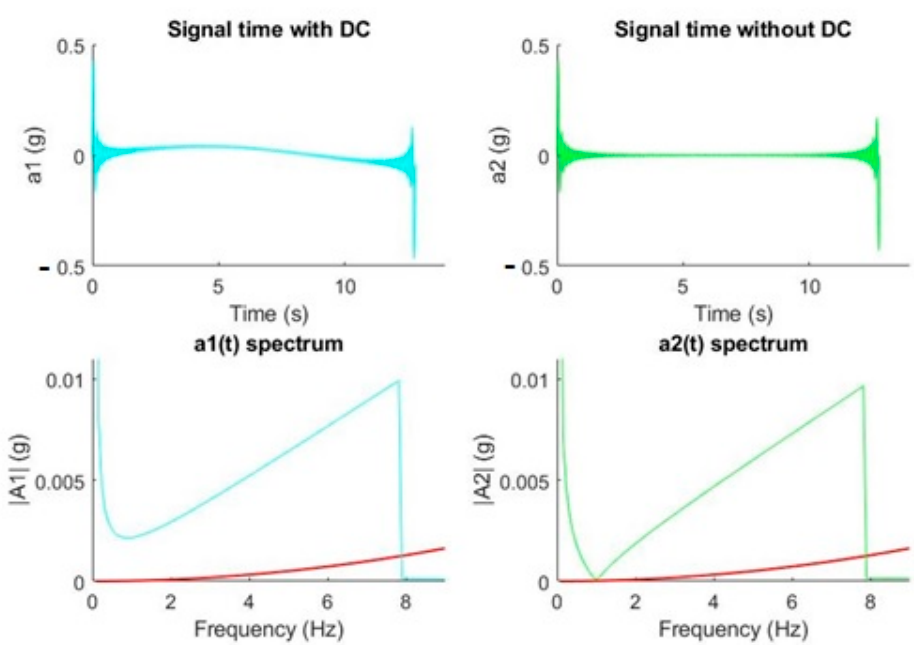
Figure 5. DC elimination effect on a synthesized signal. The red line establishes the maximum value of the acceleration.